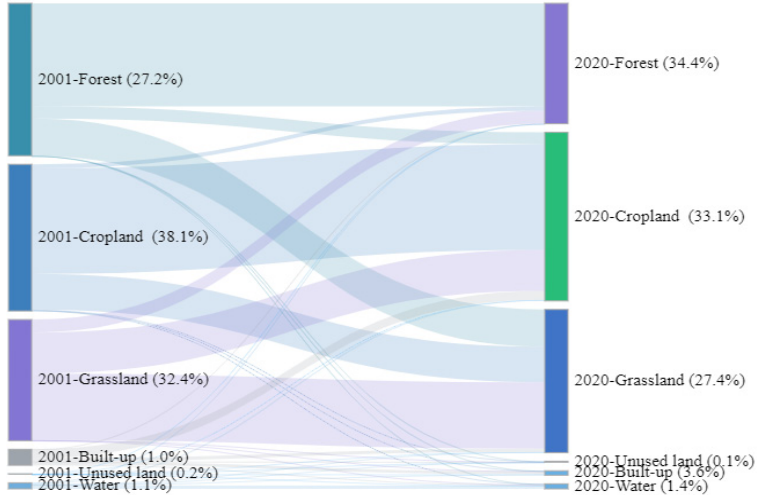
Figure 3. Graph illustrating the conversion of land use types between 2001 and 2020.